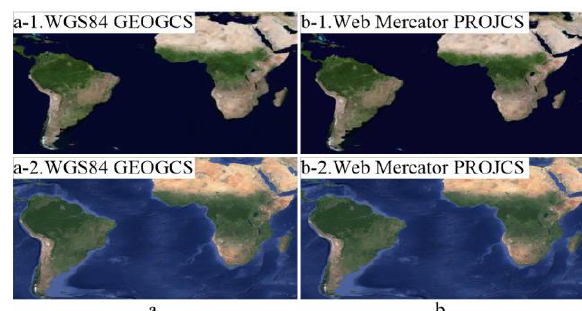
Figure 5. Diagram under the different data sources with the same spatial references (no